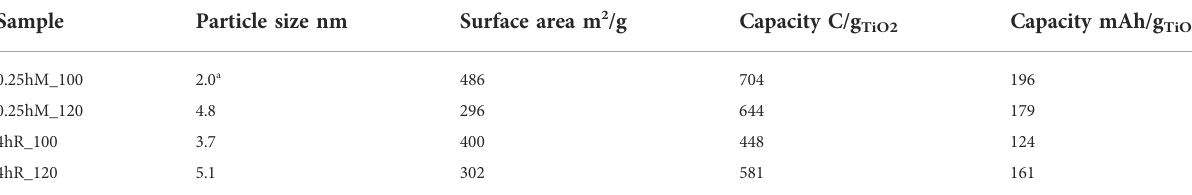
TABLE 1 TiO 2 materials prepared with different experimental conditions. Particle size, speci fi c surface area and capacity obtained in a LiPF 6 EC/PC/ 3DMC electrolyte at a current of 0.1 A g − 1 .